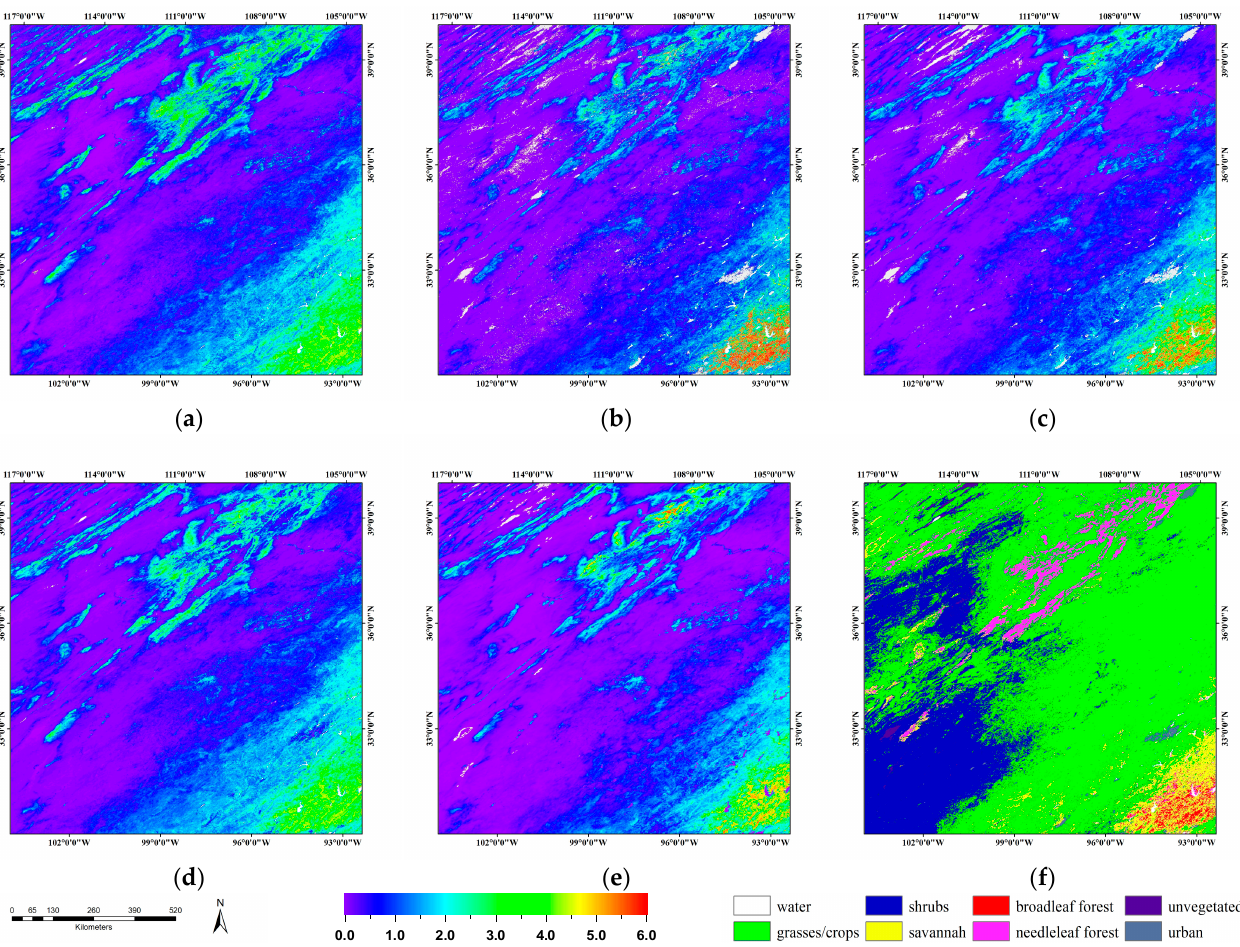
Figure 3. Maps of ( a ) VIIRS; ( b ) MODC5; ( c ) MODC6; ( d ) GLASS; and ( e ) GEOV1 LAI products for tile h09v05 on day 185, 2013. White color denotes water, and areas masked in grey correspond to pixels where these LAI products did not provide valid LAI values; ( f ) shows the MODIS 8-biomes land cover map.